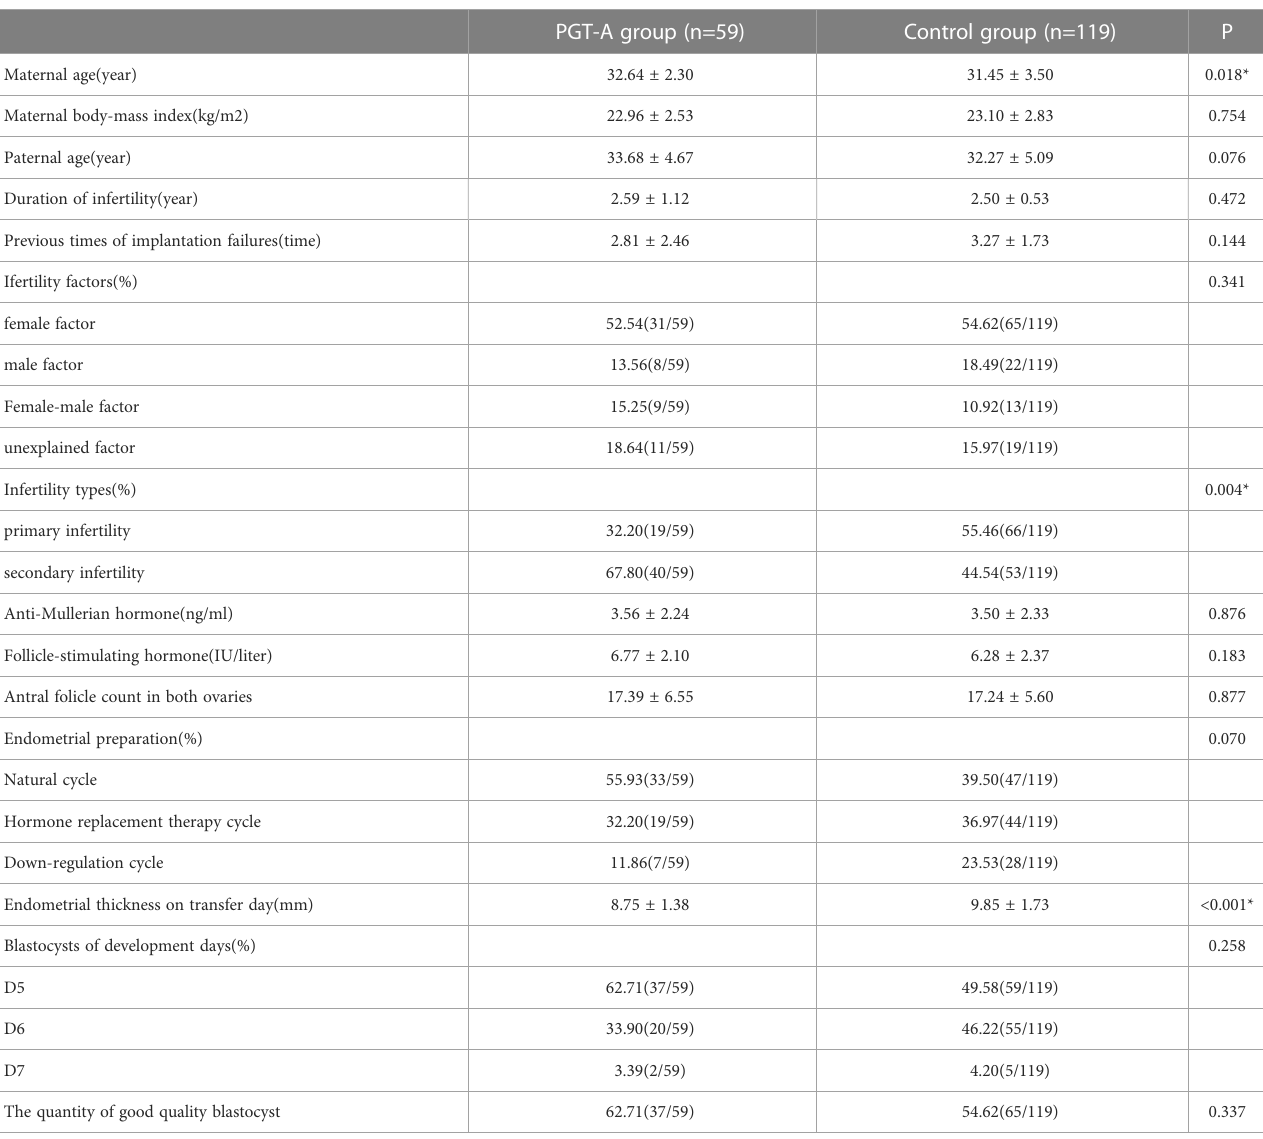
TABLE 2 Baseline demographics of PGT-A group and control